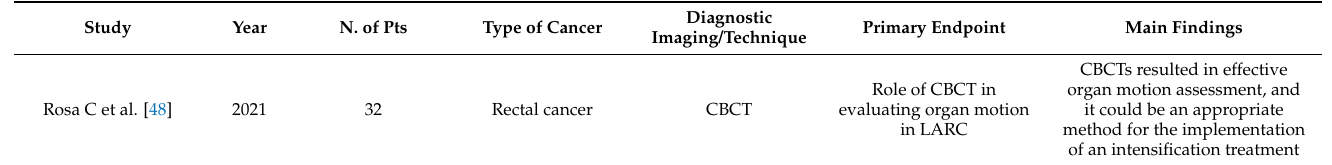
Table 5. Implementation of novel imaging in radiotherapy planning in other diseases.